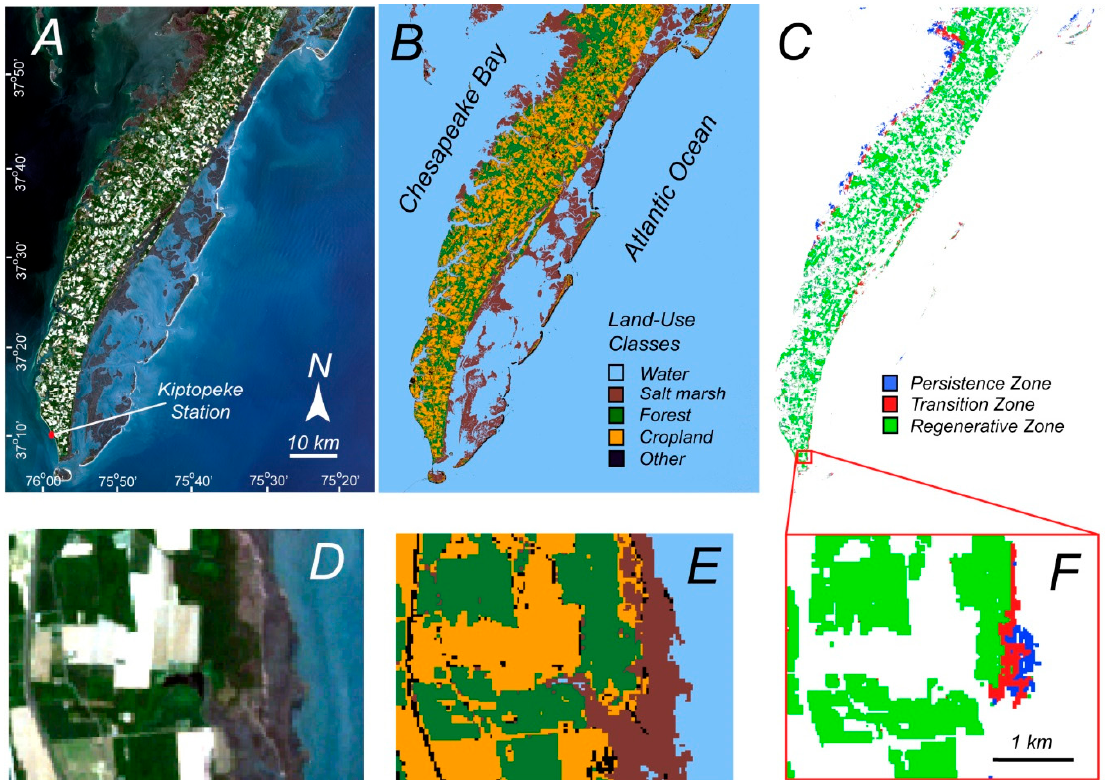
Figure 2. Delmarva peninsula along the East Coast of the USA. ( A ) Landsat 7 ETM+ C1 level 2 image taken on 4 May 2000; ( B ) land-use classes obtained with the Random Forest Classifier; ( C ) classification of persistence zone (forest below 0.92 m of elevation with respect NAVD88), regenerative zone (forest above 1.37 m) and transition zone (between 0.92 m and 1.37 m). ( D , E , F ) zoom-in of figures in the zone studied by Kearney at al. [24].